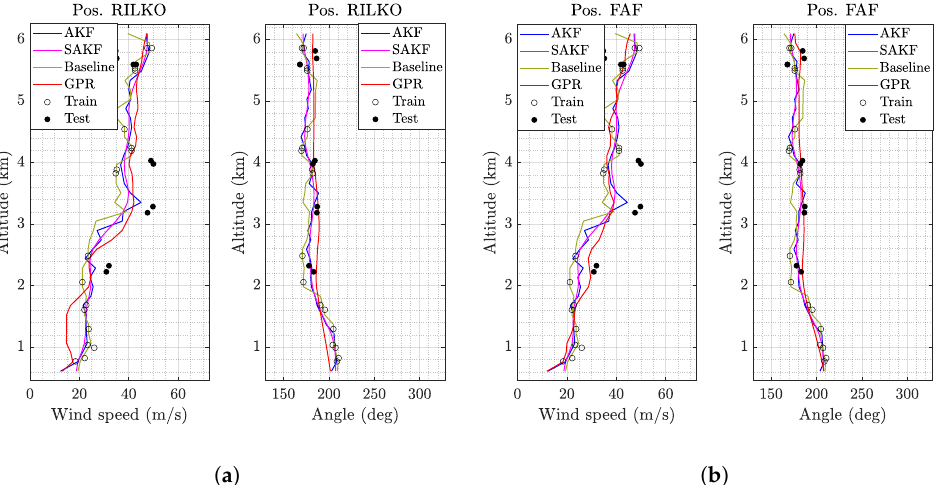
Figure 4. Estimated vector wind profiles obtained using different assimilation techniques along with the training and testing data available at 14:10 UTC. ( a ) Vector wind profile at RILKO IAF. ( b ) Vector wind profile at FAF waypoint.